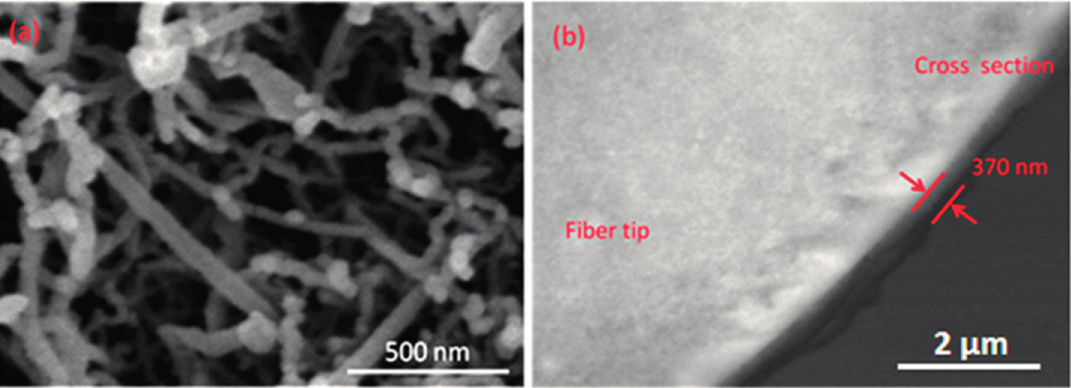
Figure 4. Field emission scanning electron microscopy (FESEM) images of carbon nanotube (CNT) ( a ) deposited on SiO 2 substrate ( b ) Cross-section deposited on tapered optical fiber